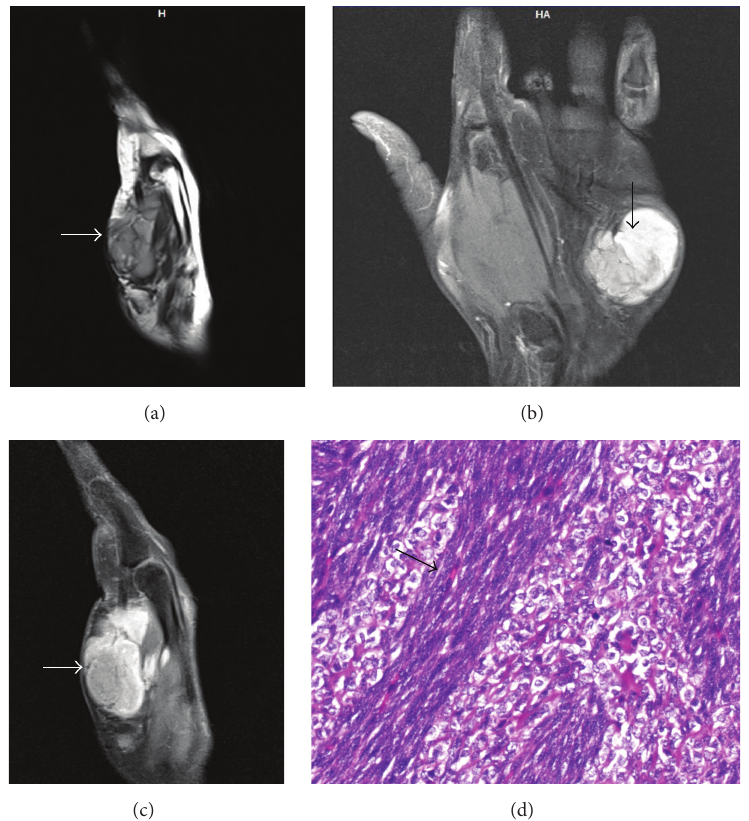
Figure 9: Synovial sarcoma. MRI (of the same patient as Figure 8). On T2W images ((a), (b)) the lesion is hyperintense (arrow). On postcontrast T1WFS images (c) the lesion shows heterogeneous postcontrast enhancement (arrow). Microphotograph (d) shows spindle shaped cells in fascicles (arrow) with intervening plump epithelial cells. H&E × 200.